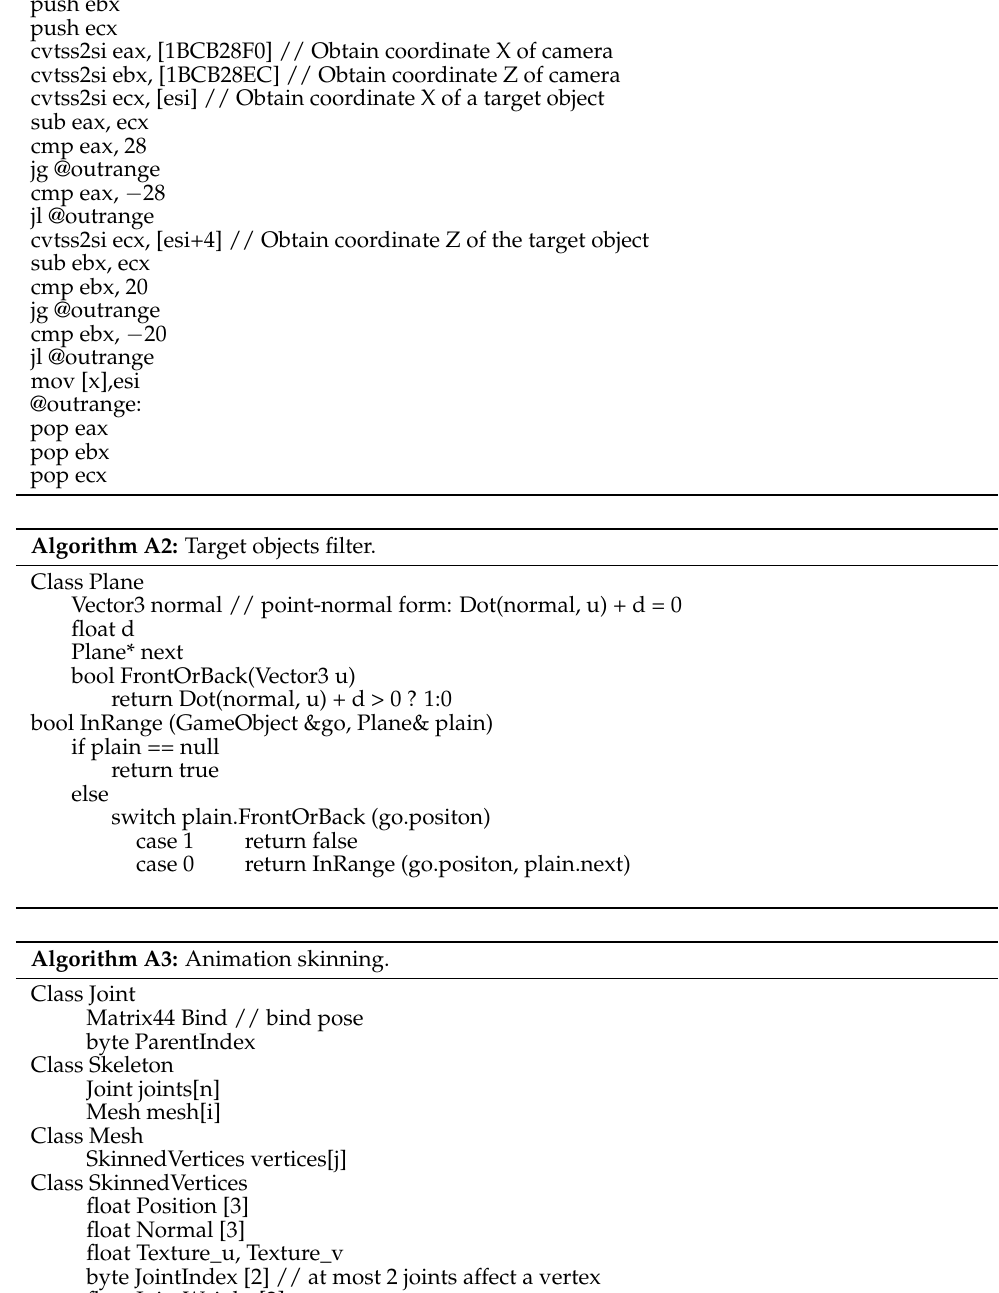
Algorithm A1: Target objects filter (assembly codes).